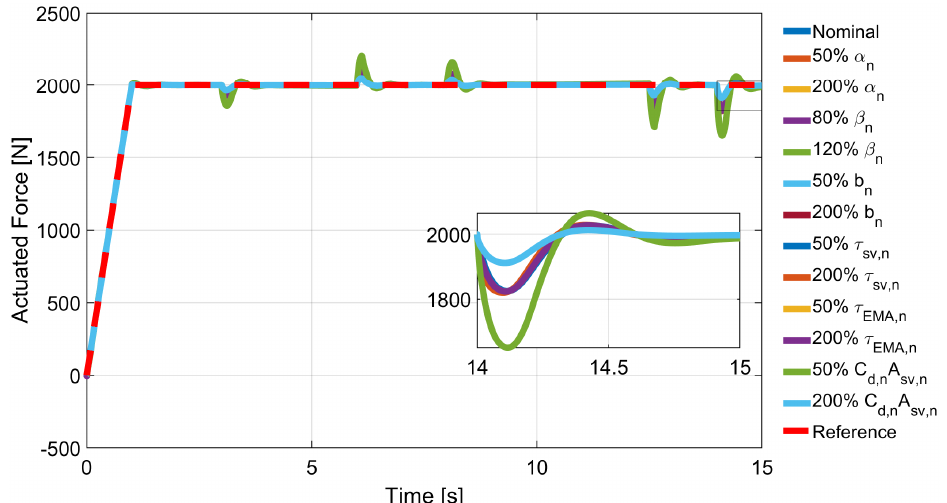
Figure 5. Simulation #1: Actuated force compared to the reference force.